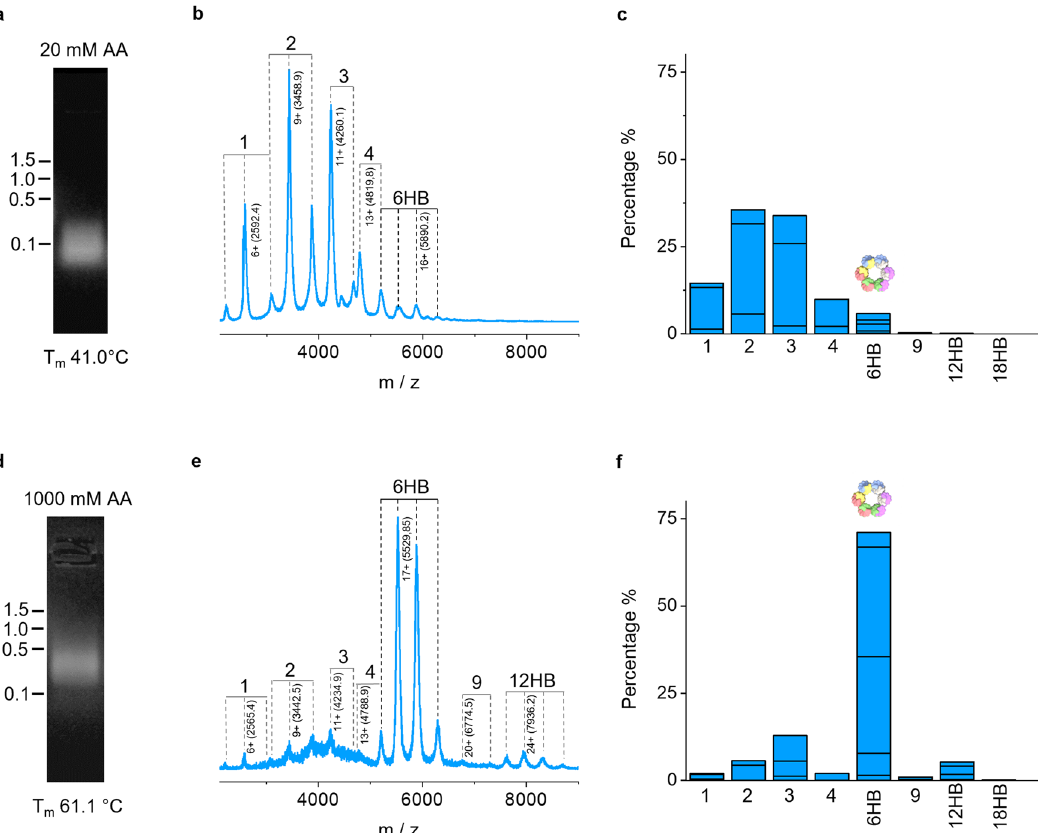
Fig. 2 Effect of different ammonium acetate concentrations (20 and 1000mM AA) on the formation of 6HB. a , d Native agarose gel. The numbers on the left indicate the molecular weight of the marker bands in kilo bases). b , e Native ESI-MS of an equimolar mixture of oligonucleotides I-VI after incubation shows the formation of hexameric 6HB but also the presence of other oligomeric species. Experimental parameters: sampling cone 125 V, trap collision energy 25 V, trap DC bias 50 V, trap pressure 4.38 × 10 − 2 mbar, and backing pressure 5.88 mbar. c , f Relative oligomer intensities at different AmAc concentrations; all species considered as indicated add up to 100% and segments in each bar indicate contributions from different charge states, with the highest at the bottom. Data for additional AmAc concentrations are shown in Supplementary Figs. 3 and